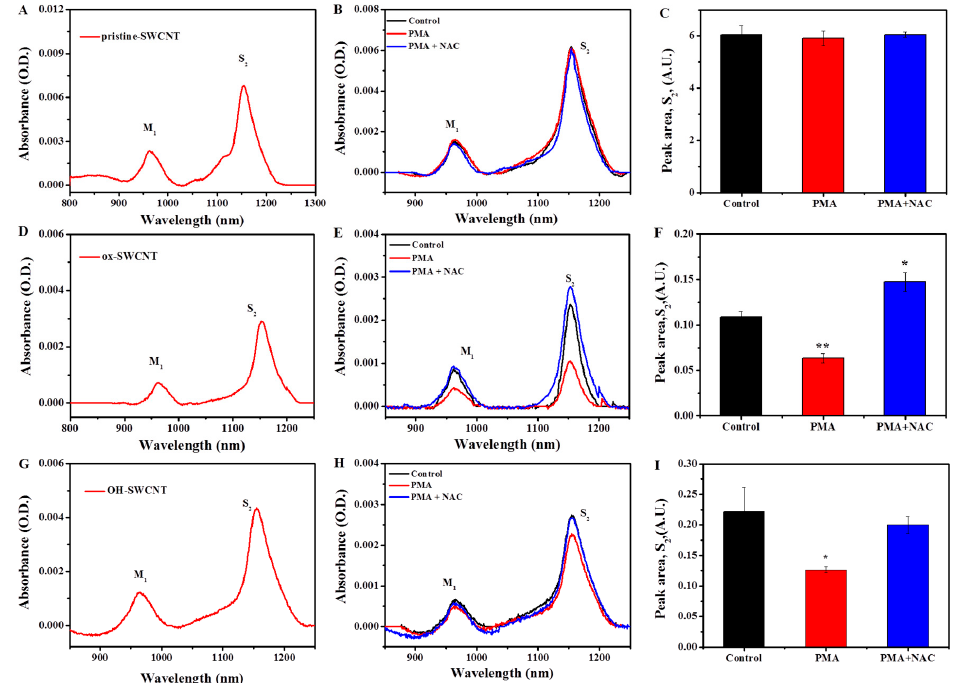
Figure 3. Biodegradation of SWCNTs in macrophages for 24 h with or without PMA activation, as evaluated by the infrared (NIR) spectra, normalized against baseline. ( A , D , G ) Typical UV-vis-NIR spectra of p-SWCNTs, ox-SWCNTs and OH-SWCNTs, respectively; ( B , E , H ) Influence of PMA and NAC treatment on the absorbance of M 1 and S 2 bands of p-SWCNTs, ox-SWCNTs and OH-SWCNTs in macropahges, respectively. Black line: control macrophages (untreated); Red line: PMA-activated macrophages; Blue line: PMA-activated macrophages with NAC pretreatment; ( C , F , I ) Quantification of the peak area of characteristic semiconducting transition band (S 2 ) of ( C ) p-SWCNTs; ( F ) ox-SWCNTs; and ( I ) OH-SWCNTs in macrophages. Results were from at least three independent experiments and expressed as mean ± S.D. (* p < 0.05; ** p < 0.01).